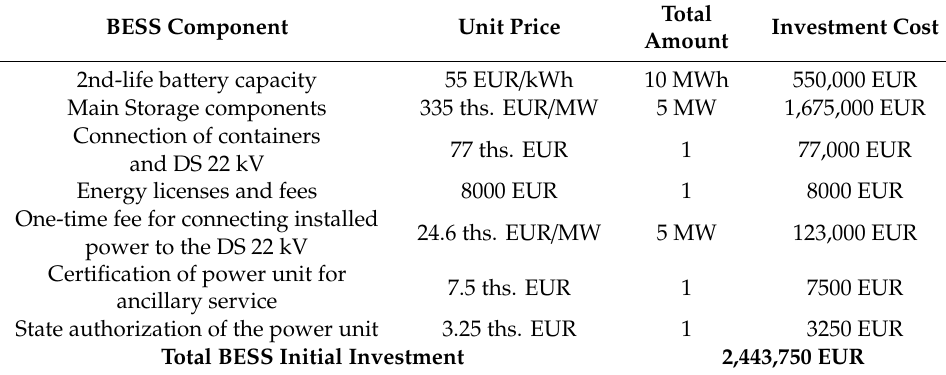
Table 8. Assessment of the BESS initial investment (authors own